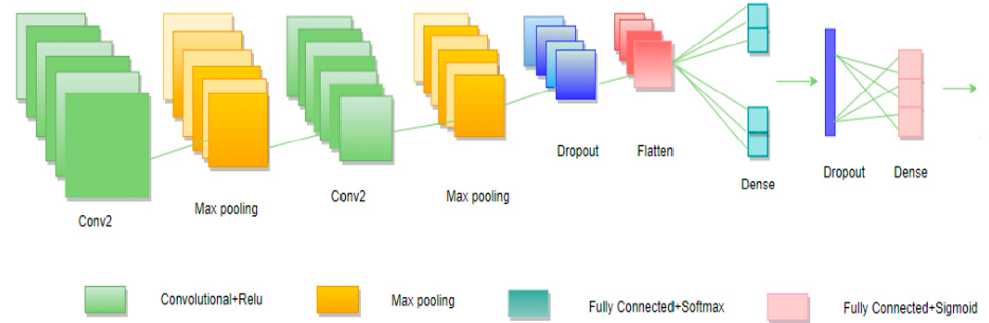
Figure 6. Convolutional neural networks.